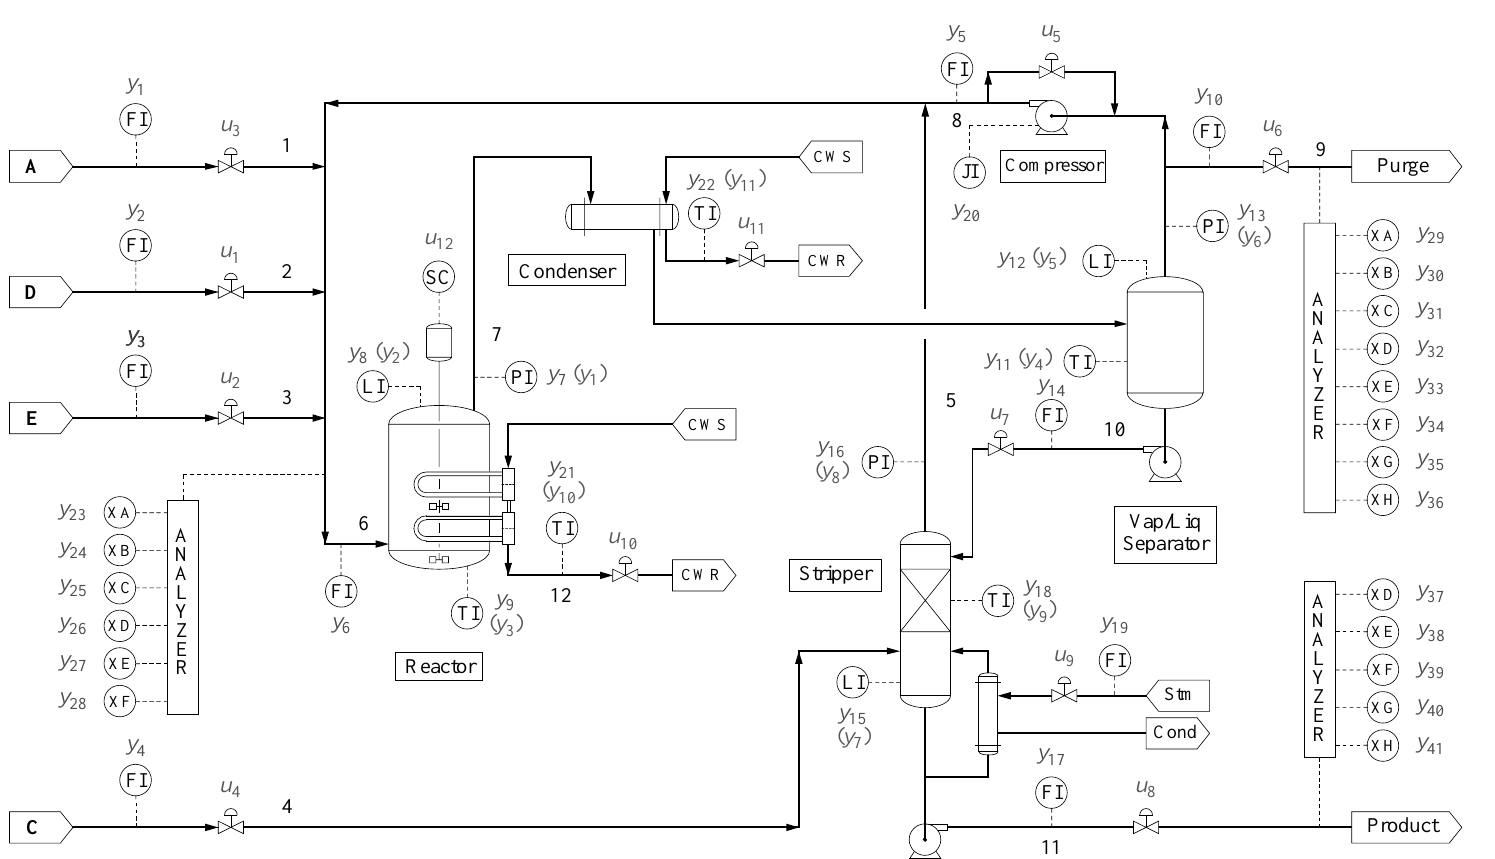
Figure 3. Tenessee Eastman process